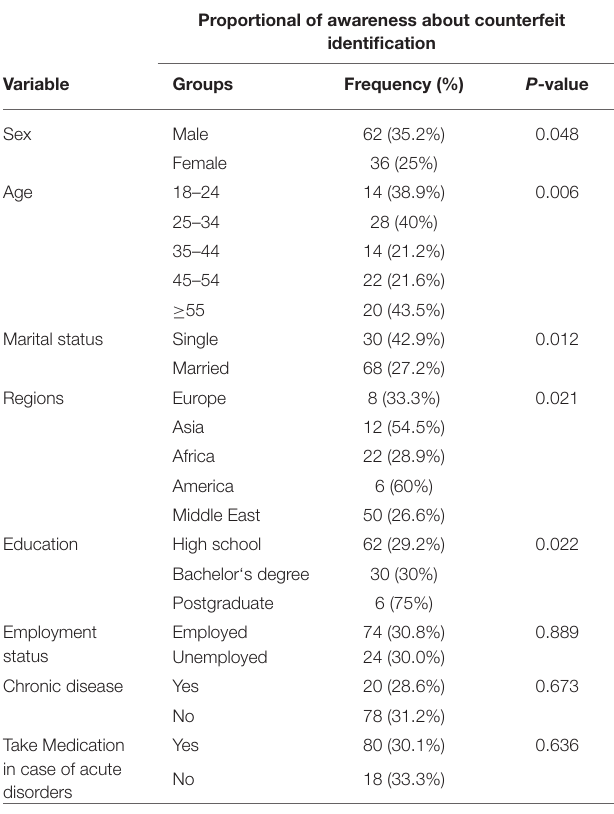
TABLE 4 | Counterfeit identification according to demographic